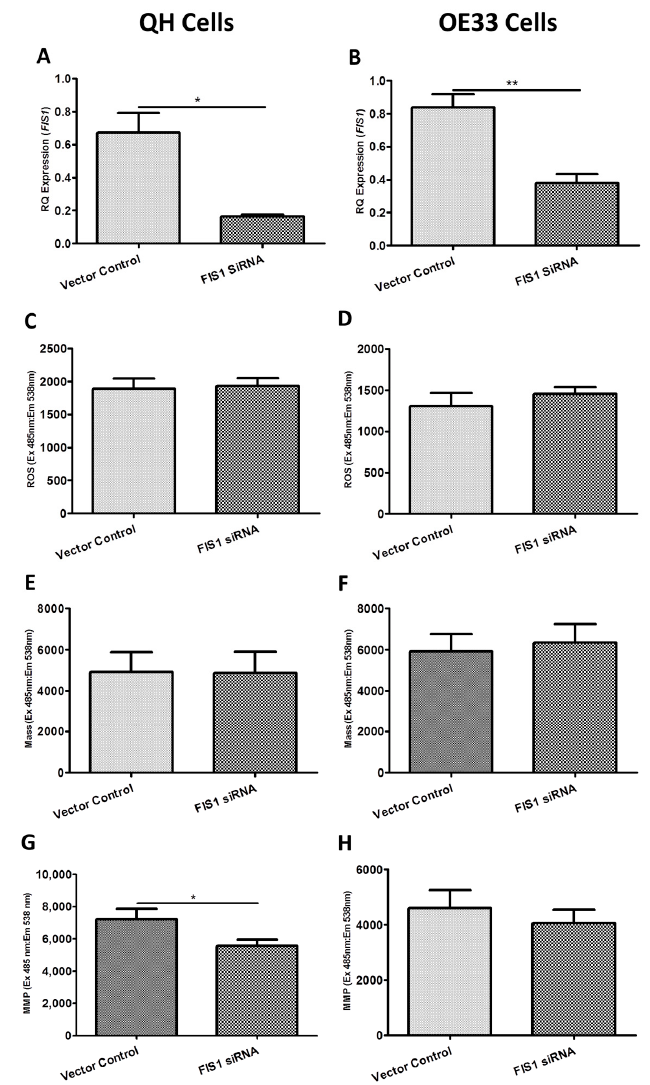
Figure 4. Functional effect of FIS1 siRNA knockdown on reactive oxygen species (ROS) production, mitochondrial mass and mitochondrial membrane potential (MMP) in the QH (Barrett’s) and OE33 (adenocarcinoma) cell lines in vitro . ( A ) FIS1 gene expression was significantly knocked down (75.9%) in the FIS1- siRNA treated QH cell line ( p = 0.0242). ( B ) FIS1 gene expression was significantly knocked down (54.8%) in the FIS1- siRNA treated OE33 cell line ( p = 0.0037). ( C ) FIS1 knockdown had no significant effect on ROS production in QH ( p = 0.4112) and ( D ) OE33 cell lines ( p = 0.2401). ( E ) FIS1 knockdown had no significant effect on mitochondrial mass in the QH cell line ( p = 0.9245) or in the ( F ) OE33 cell line ( p > 0.05). ( G ) FIS1 knockdown significantly decreased MMP in the QH cell line ( p = 0.0190) but ( H ) had no significant effect on MMP in the OE33 cell line ( p = 0.3124). Paired t -tests assessed statistical differences between vector control and siRNA treated QH ( n = 4) and OE33 ( n = 4) cells. Bars denote mean ± SEM. * p < 0.05 and ** p <